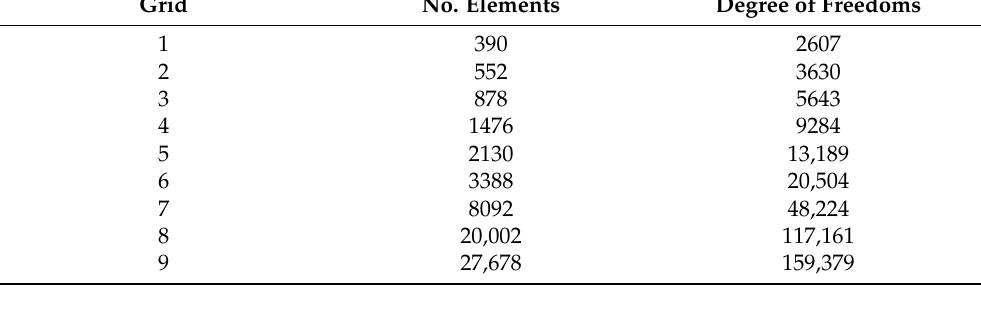
Figure 3 A computational grid at finer-level mesh.